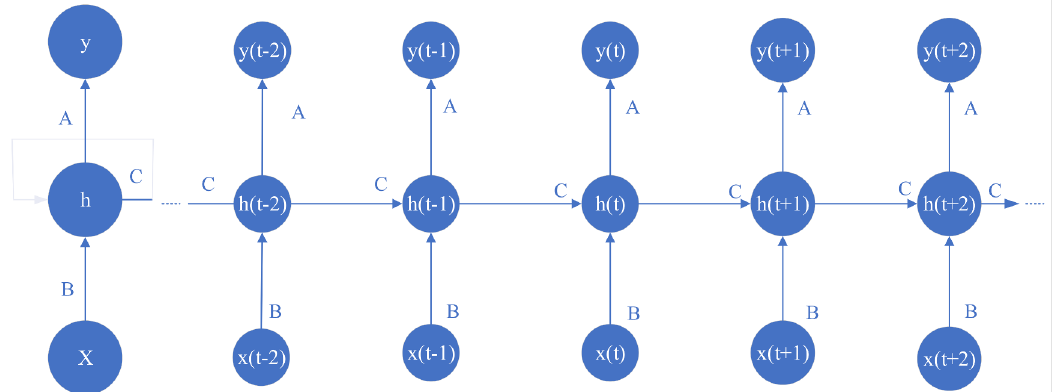
Figure 18. Working flow of recurrent neural